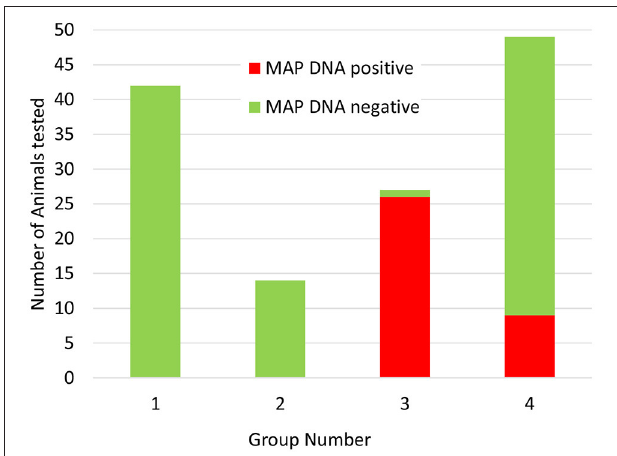
FIGURE 2 | Distribution of Actiphage MAP test results in commercial deer herd production groups. Blood samples were taken from 132 female deer prior to the rutting season. The samples were supplied to the lab blinded to production group. After the test results were available, the samples were unblended and sorted by production group. Green bars indicate negative MAP test results; red bars indicate positive MAP test